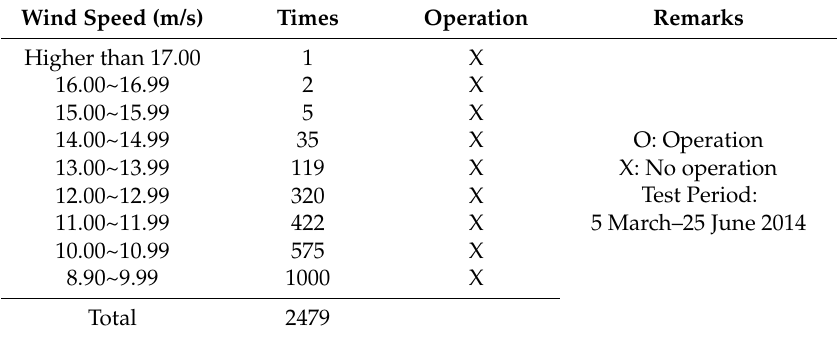
Table 6. Wind speed during